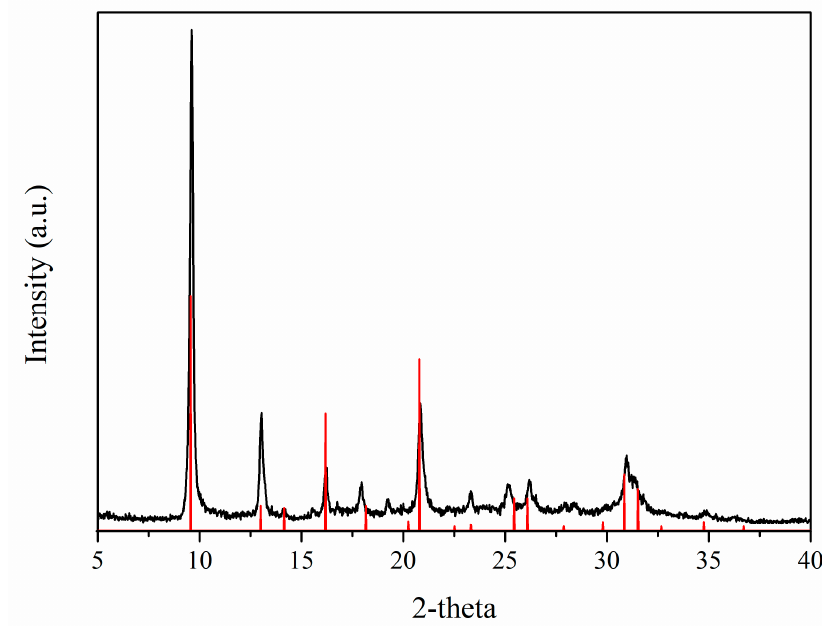
Figure 2. X-ray diffractogram of the synthesized SAPO-34. Reference 2-theta values are shown for comparison [32].